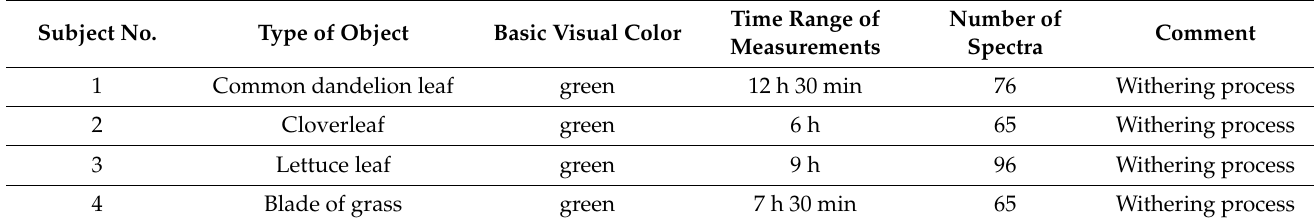
Table 1. Test subjects with optical parameters changing over time.